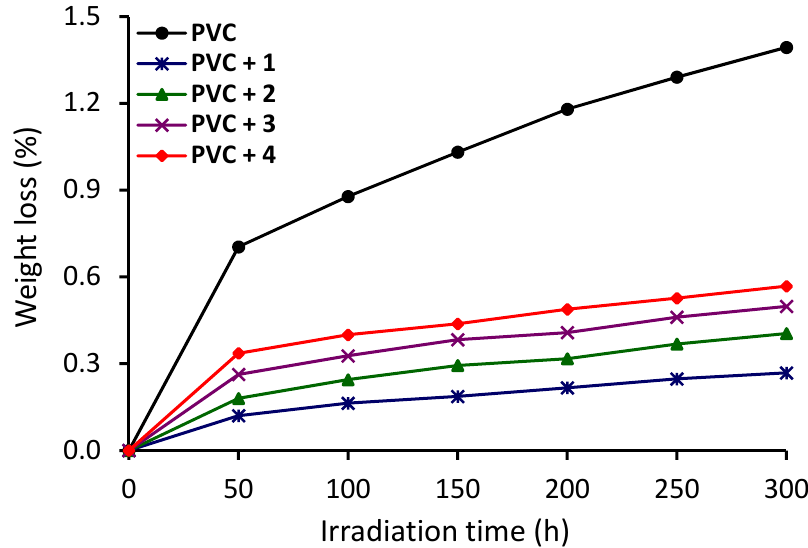
Figure 5. Weight loss (%) of PVC films versus time.